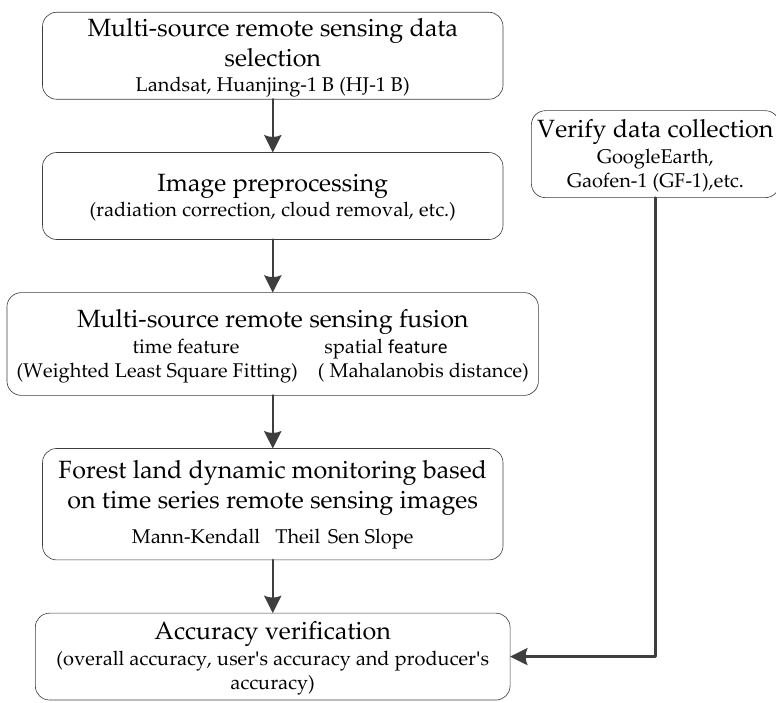
Figure 2. Data processing and analysis flow chart.